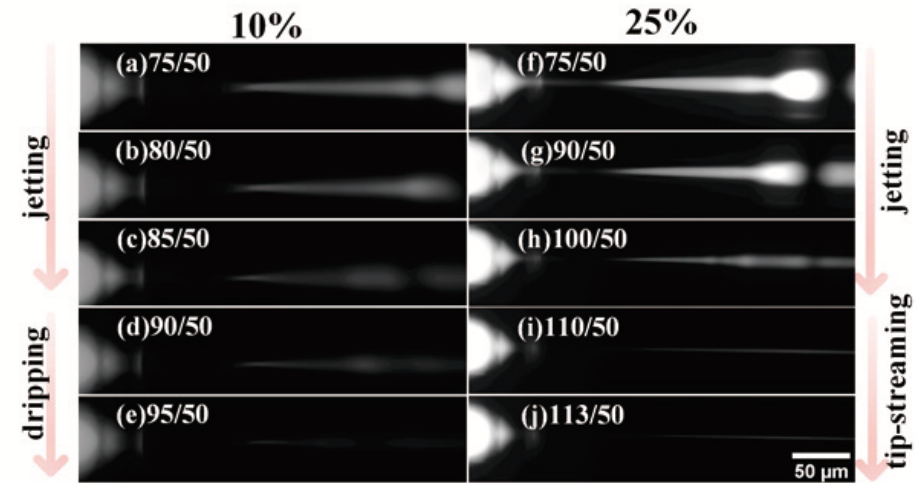
Figure 3. Representative fluorescent images of the transition of droplet breakup processes at bulk concentration of surfactant of 10 vol % and 25 vol %, including ( a – d , f – h ) jetting mode, ( e ) dripping mode and ( i , j ) tip-streaming